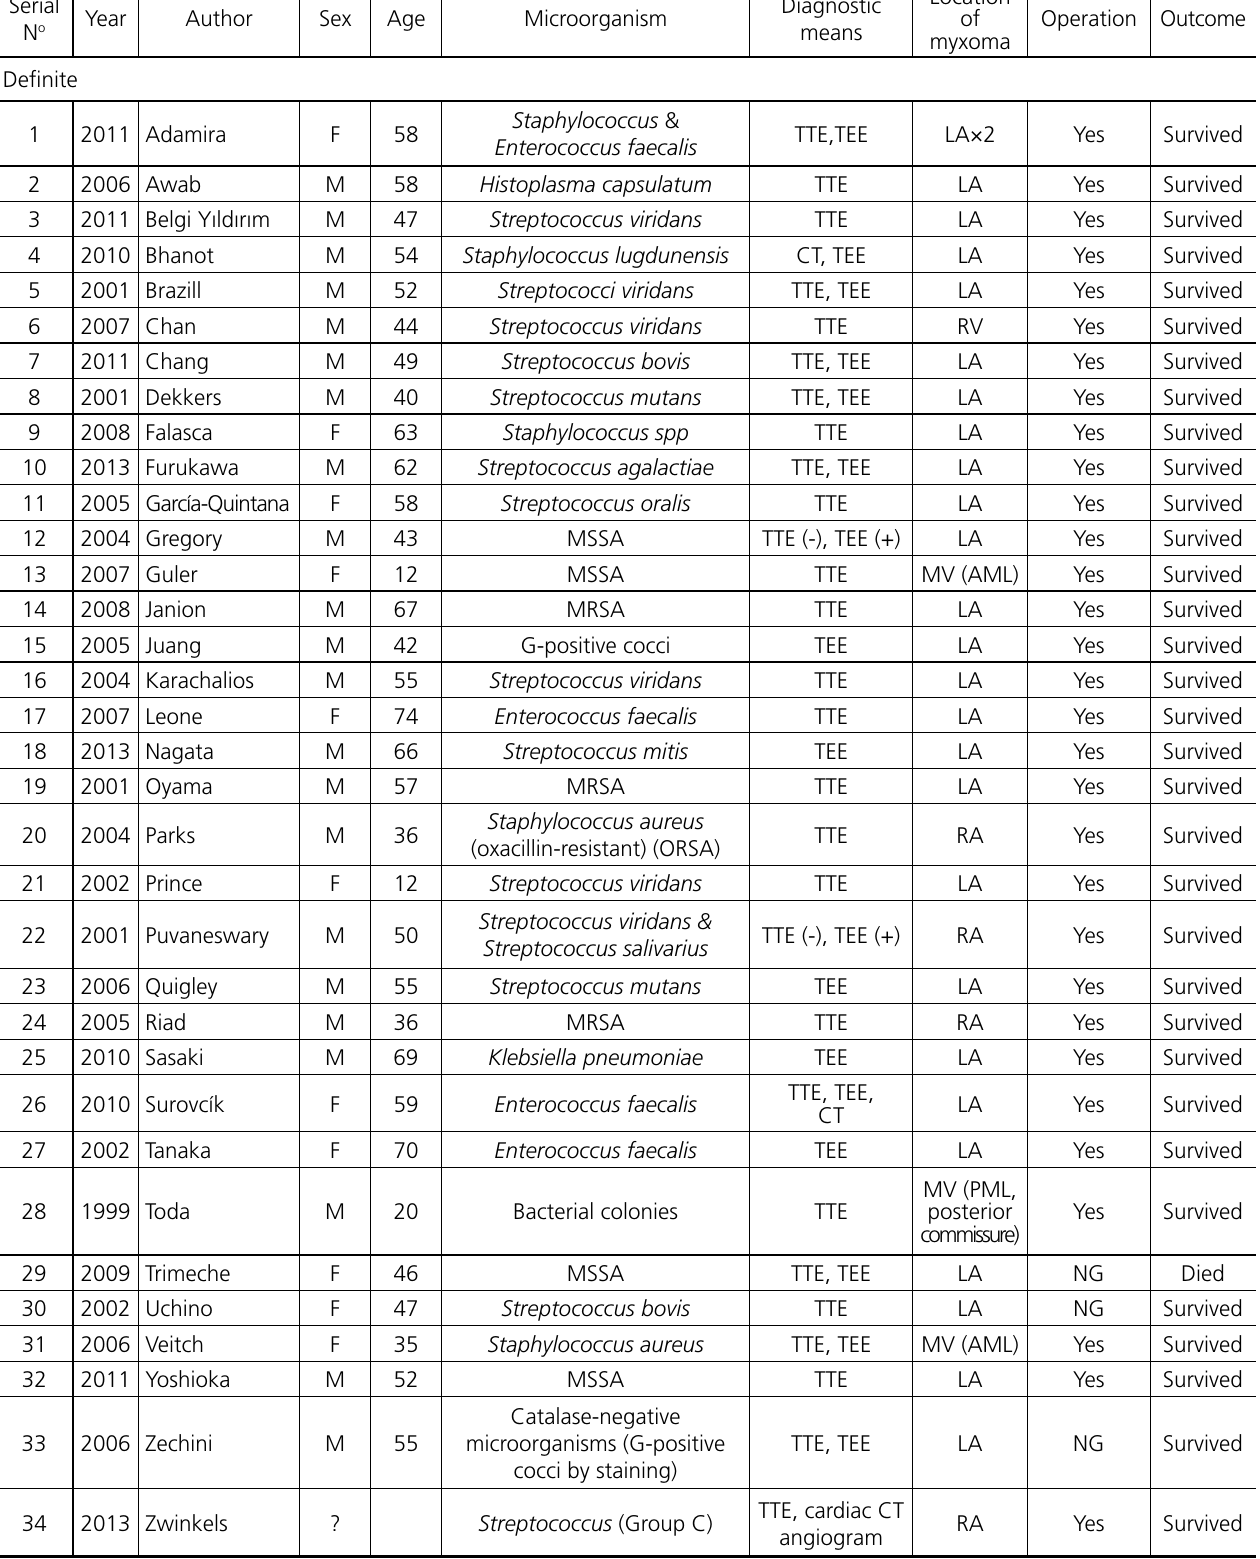
Table 1. Summary of 39 patients with infected cardiac